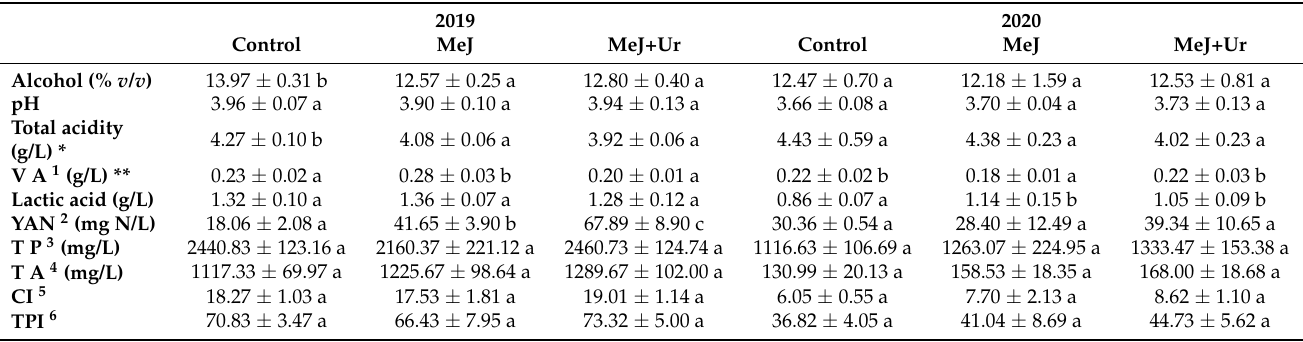
Table 1. General parameters in wines from control, methyl jasmonate (MeJ) and MeJ+Urea (MeJ+Ur) treatments, in 2019 and